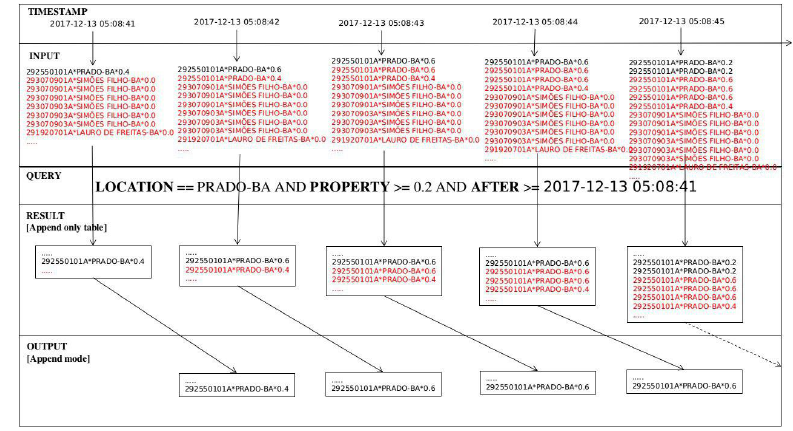
Figure 21. Spark Append